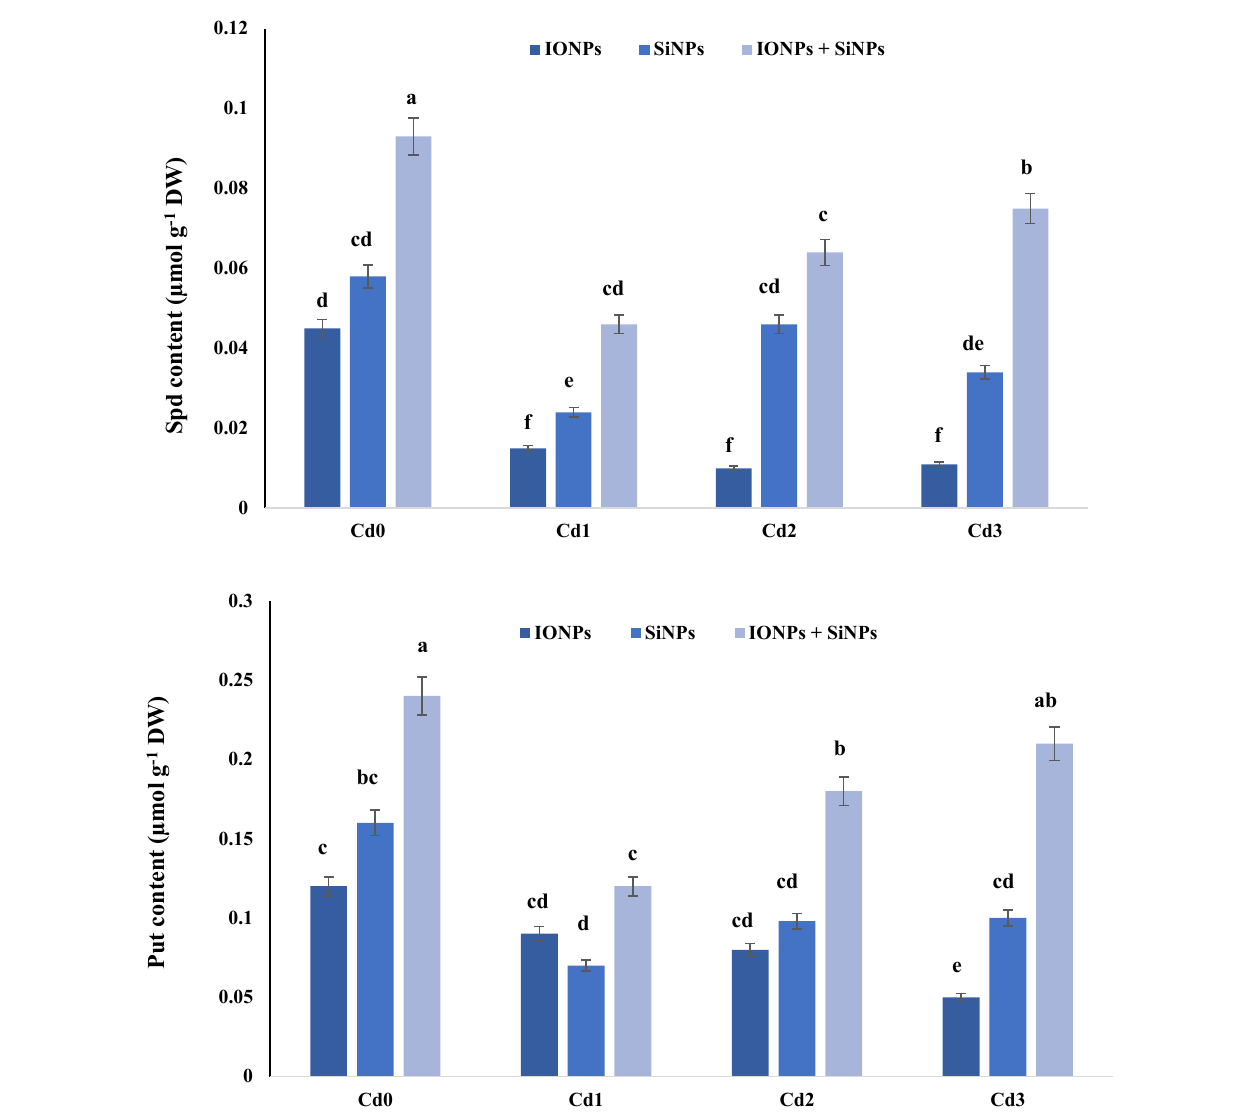
FIGURE 3 | Effect of IONPs and SiNPs on PAs content of Phaseolus vulgaris grown in different concentrations of Cd. Here IONPs, SiNPs, Cd0, Cd1, Cd2, and Cd3 indicate iron oxide nanoparticles, silicon nanoparticles, 0 mM CdCl 2 , 1 mM CdCl 2 , 1.5 mM CdCl 2 , and 2 mM CdCl 2 . Different letters indicate significant difference among the treatments ( P ≤